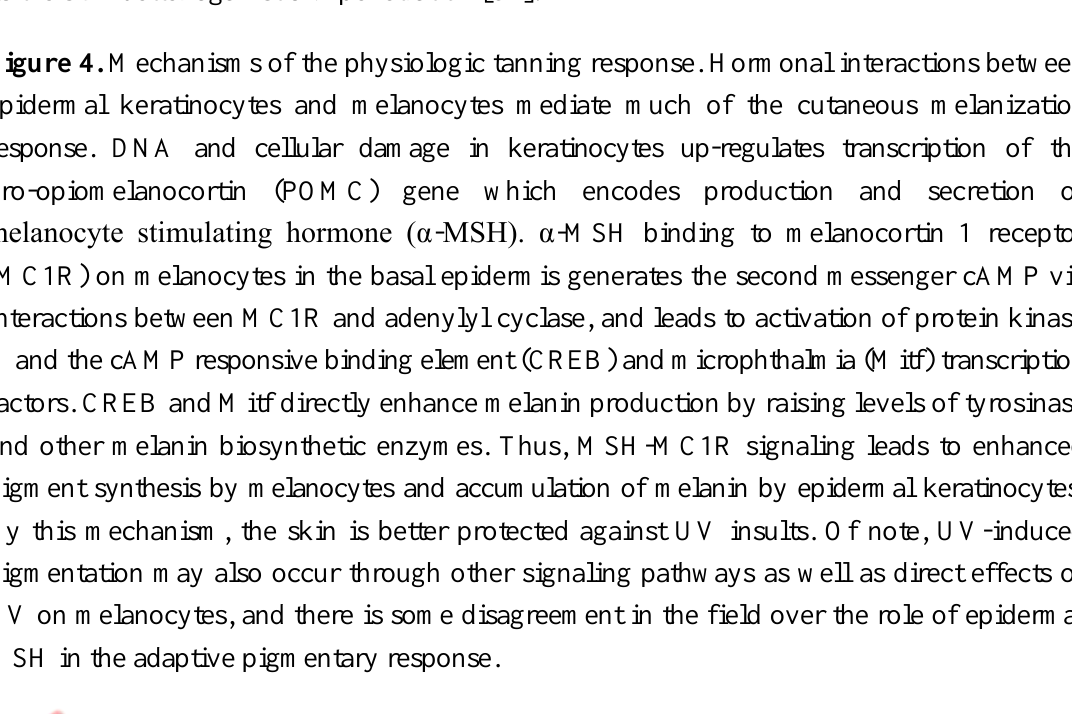
Figure 4. Mechanisms of the physiologic tanning response. Hormonal interactions